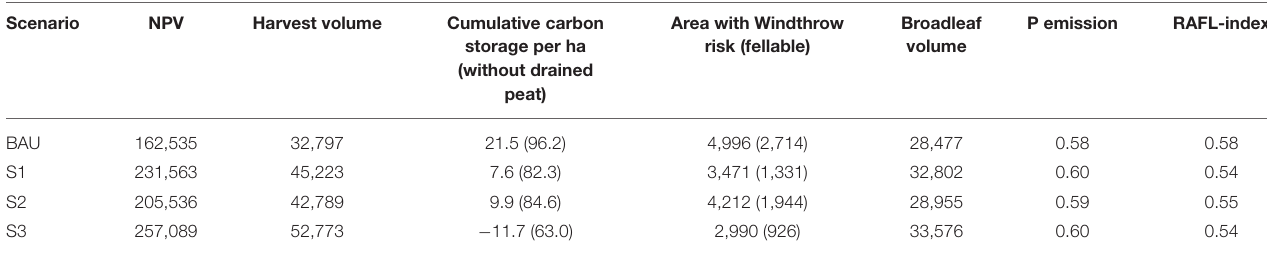
TABLE 4 | Annual average ES indicator values for the four scenarios: cumulative carbon storage (tons ha − 1 ) with and without (in brackets) the impact of drained peat soils, the total area at 70% windthrow risk (ha) and the fellable area (in brackets), total broadleaf volume (m 3 ), average P emissions from forests (kg ha − 1 ) and average RAFL index per